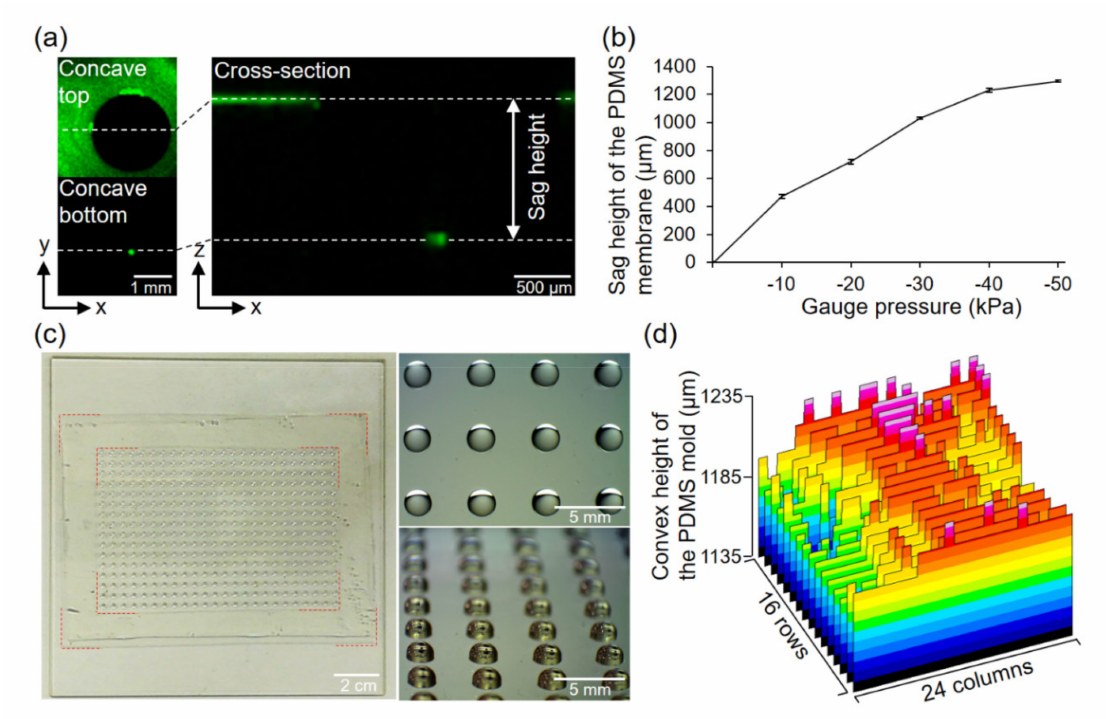
Figure 3. Characterization of PDMS membrane deformation and convex PDMS mold. ( a ) The laser reflection from the surface of the PDMS membrane. ( b ) Sag height of the PDMS membrane at di ff erent negative gauge pressures ( n = 4). ( c ) Left: Photograph of the entire PDMS mold on the glass substrate. The red-dotted line indicates the edge of the thin silicone frame. Right: Close-up image of the mold from above (upper) and diagonally above (bottom) observed with a stereo microscope (S8 APO, Leica Microsystems Japan, Tokyo, Japan). ( d ) Height profile of all convexes on the